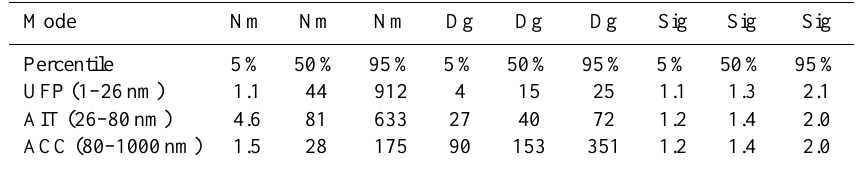
Table 5. Statistics of mode parameters of the summer aerosol in the central Arctic in the three diameter ranges UFP: 1–26nm, AIT: 26– 80nm, and ACC: 80-1000nm. Nm=total number per mode in cm − 3 , Dg=geometric mean diameter innm, and Sig=geometric standard